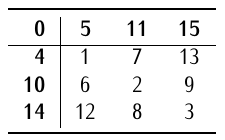
Table 1. 4x4 grid: Pair-On-Pair (PoP): quorum (0,0) in bold